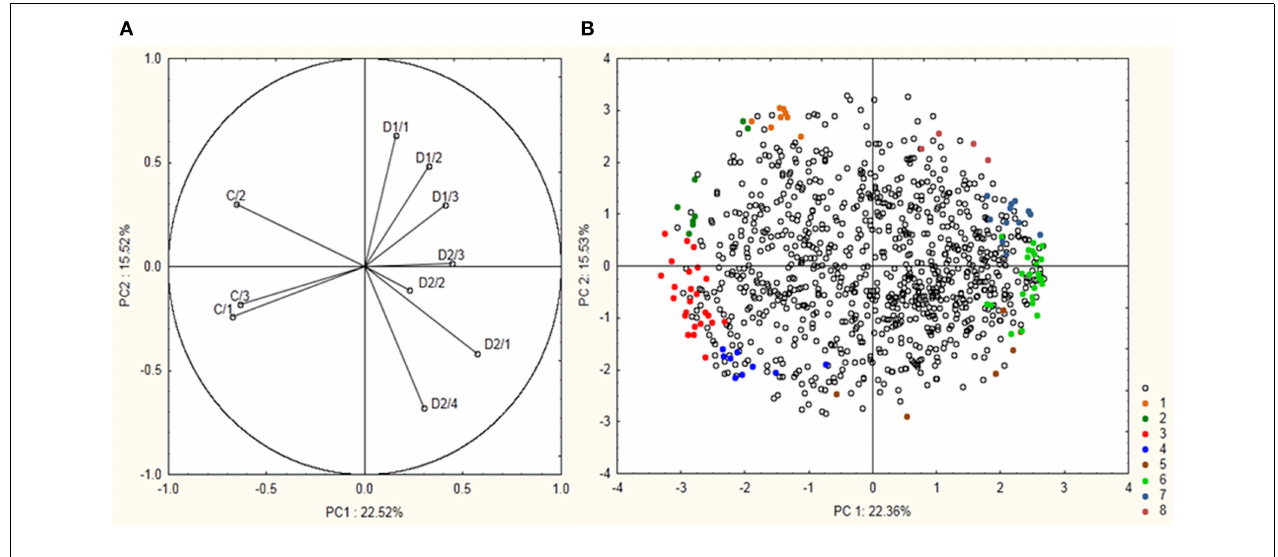
FIGURE 4 | Results of PCA analysis showing a position of 99 protein spots revealing significant differences between experiment variants and selected for protein identification. (A) Position of the individual samples (control—C1–C3; drought